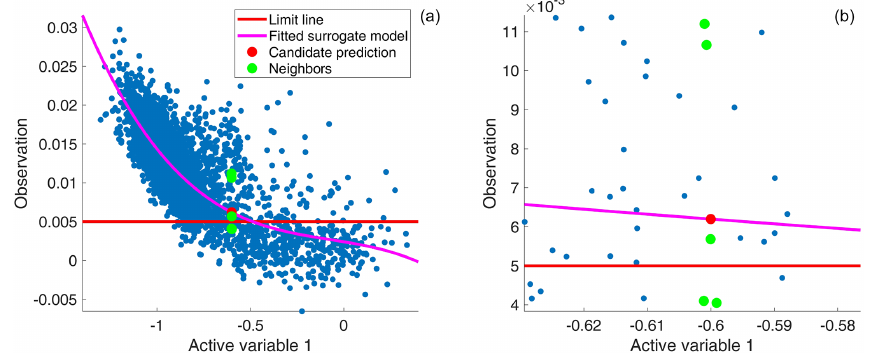
Figure 2. Illustration of the two active-subspace sampling schemes, shown for a 1-D test. Panel (b) shows a zoom into (a) . Blue dots: previously analyzed points; magenta line: fitted polynomial surrogate model; red dot: candidate parameter in active subspace ( x value) with the assigned polynomial prediction ( y value) of the original sampling scheme; green dots: neighbors considered in the new scheme, which are chosen exclusively by the active-variable value; red line: behavioral limit line. Here, points above the red line are considered to have acceptable behavior.